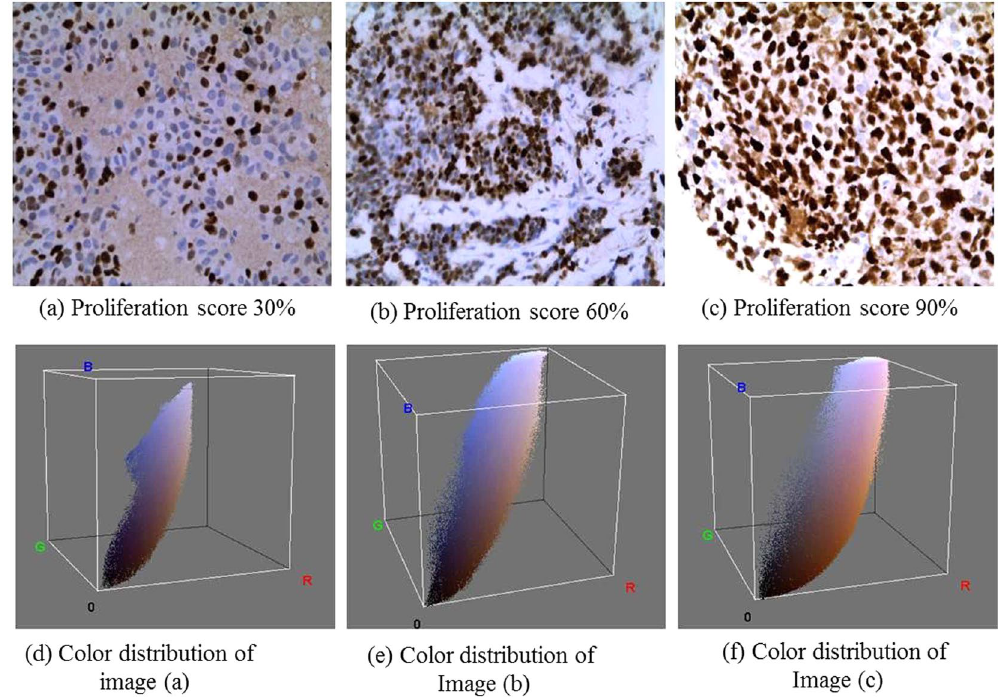
Figure 1. Ki-67 proliferation scoring by the pathologists with respect to differential color distribution: Three input Ki-67 stained images of breast cancer at 40 × with the scores ( a ) = 30%; ( b ) = 60%; ( c ) = 90%; and color spectrum visualization of the inputs images ( d–f